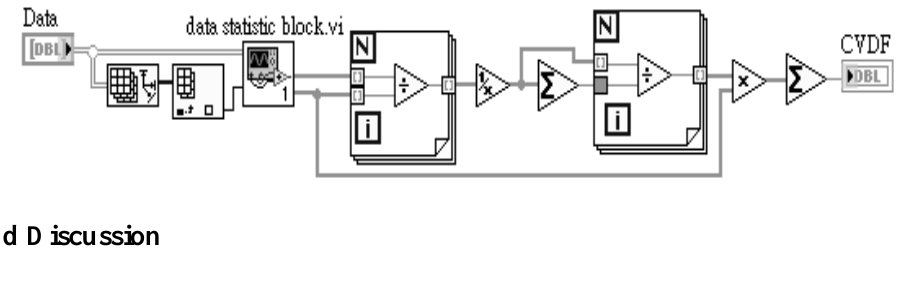
Figure 7. LabVIEW block diagram of coefficient of variance data fusion used for RuO based pH sensor array.